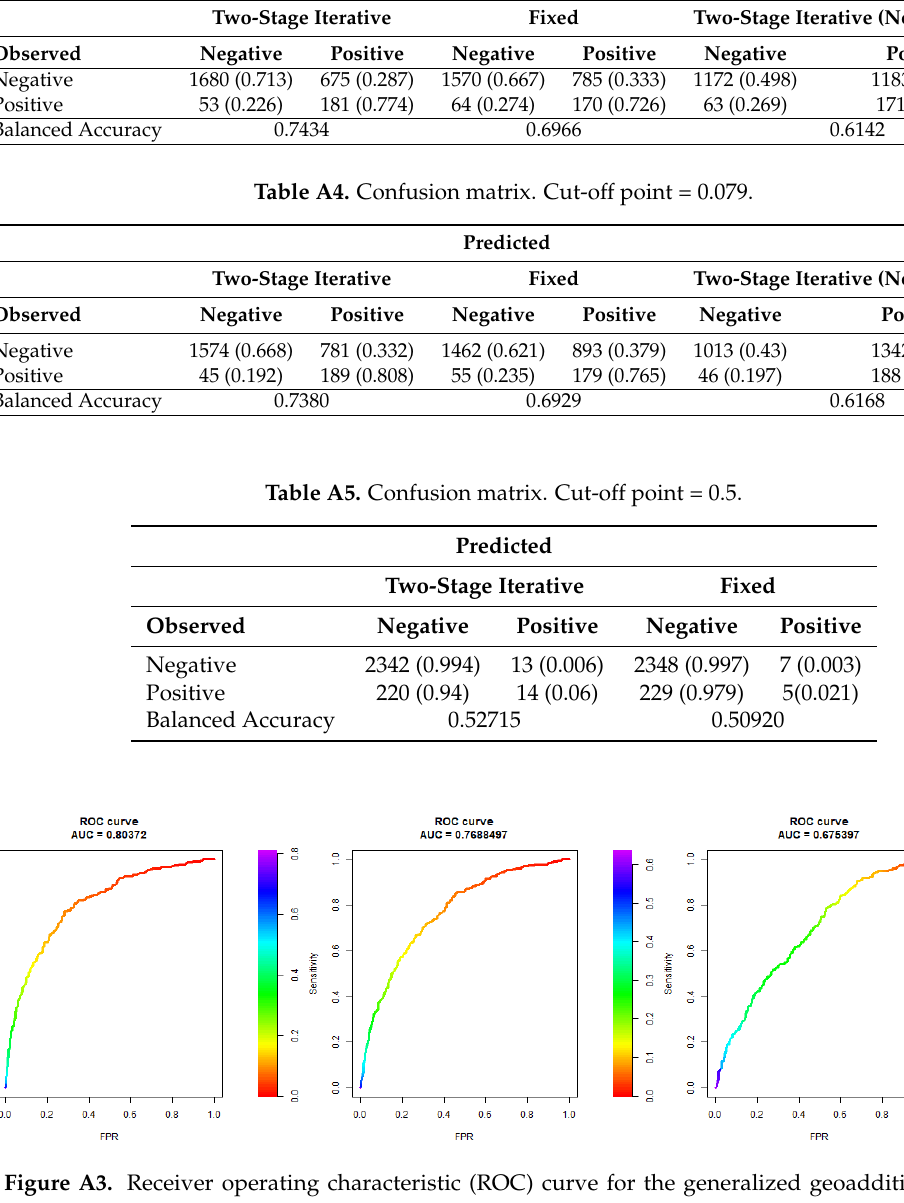
Figure A3. Receiver operating characteristic (ROC) curve for the generalized geoadditive model. The plot on the left corresponds to the ROC curve for the model fitted using the two-stage iterative method. The plot in the middle is for the model fitted with τ fixed to the maximum distance. The plot on the right is for the model fitted with the two-stage iterative method but with no covariates. All three models consider a Gaussian covariance